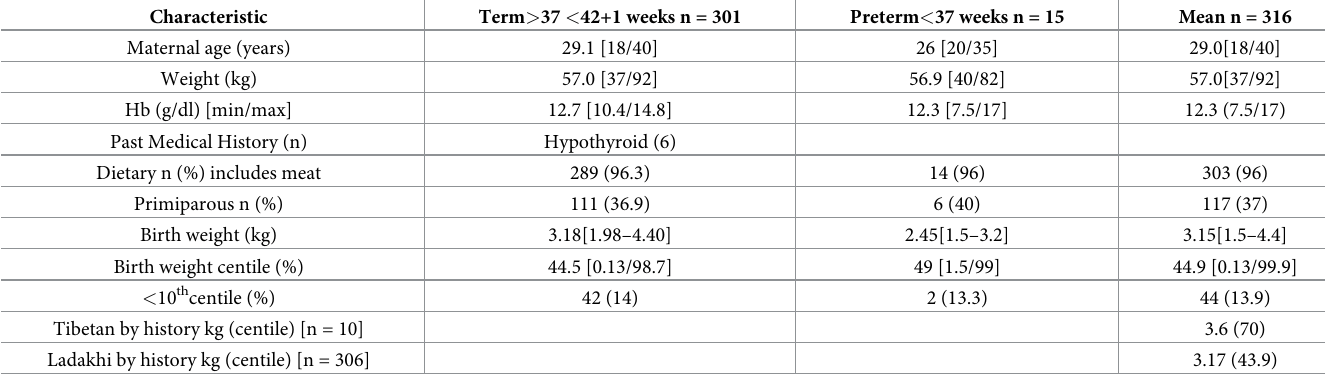
Table 1. Maternal and fetal